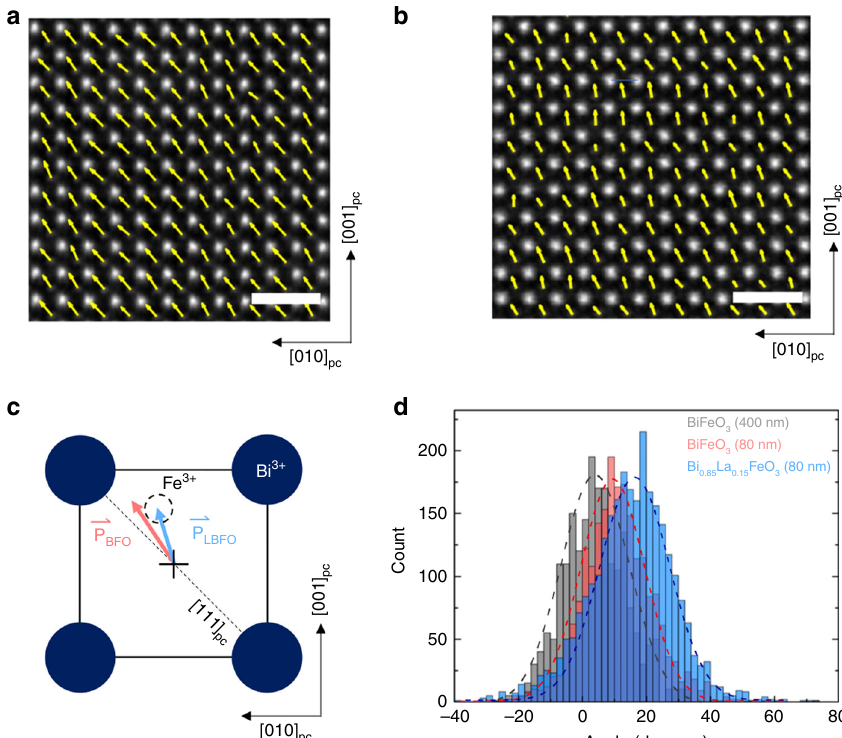
Fig. 2 Atomic images, polarization mapping, and change of polarization in BiFeO 3 and Bi 0.85 La 0.15 FeO 3 thin fi lms. a , b show the HAADF-STEM images of BiFeO 3 and Bi 0.85 La 0.15 FeO 3 , respectively, with the polarization mapping of the Fe atoms overlaid. The scale bar is 1 nm. c Schematic of ferroelectric polarization in BiFeO 3 /Bi 0.85 La 0.15 FeO 3 unit cell. The vectors in ( a , b ) were extracted from the displacement of Fe 3 + position to the mass center of four Bi 3 + . d Histogram of polar distribution shows that the ferroelectric polarizations rotate 3.6°, 10.9° and 16.1° away from [111] pc in 400-nm-thick BiFeO 3 (gray), 80-nm-thick BiFeO 3 (red) and 80-nm-thick Bi 0.85 La 0.15 FeO 3 (blue),